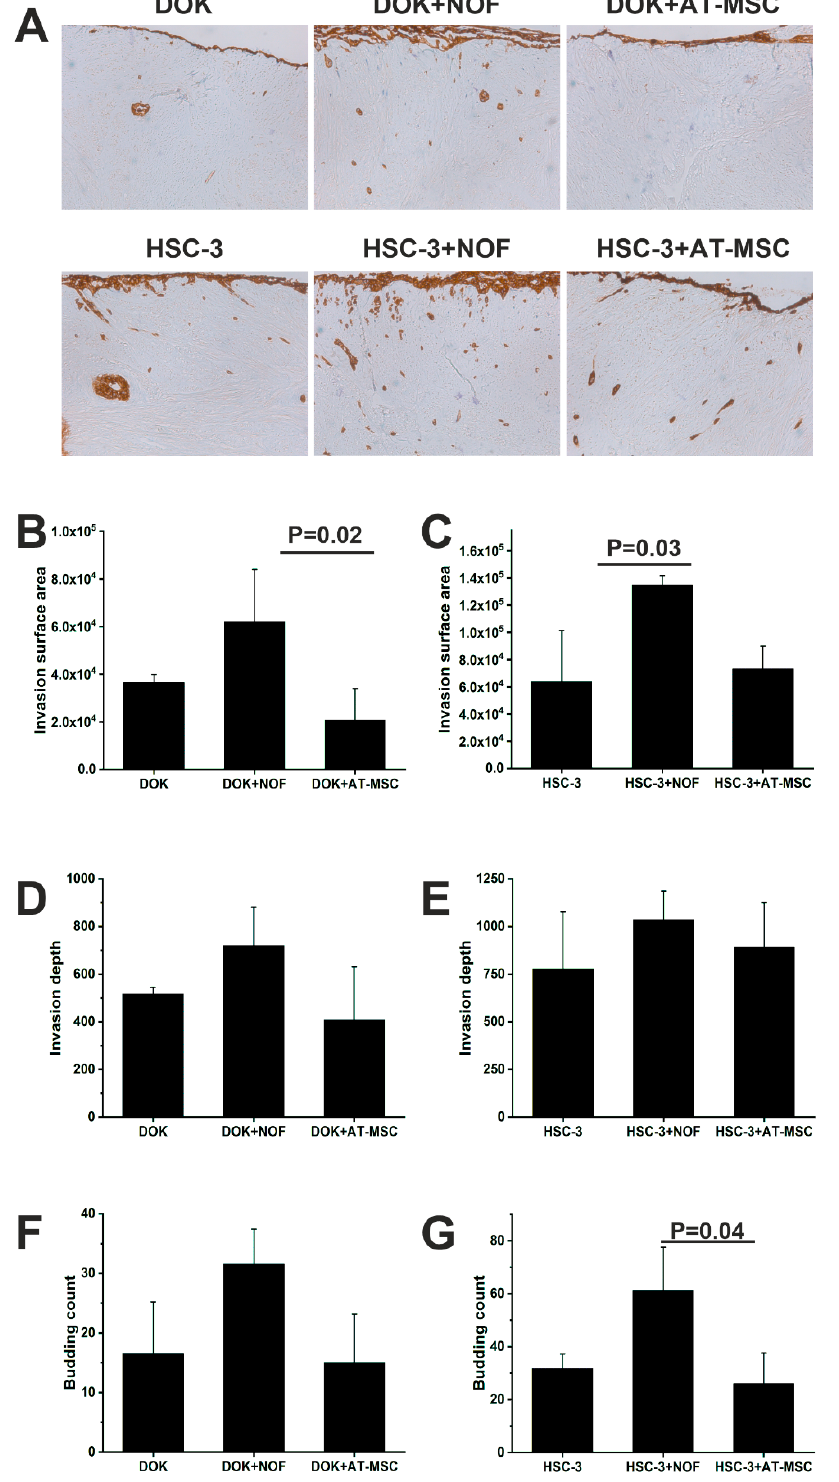
Figure4. InvasionofDOKandHSC-3cellswasnotaffectedbythepresenceofAT-MSCs. ( A )Representative pictures of the pan-cytokeratin-stained cells in the myoma discs, pictures were taken at magnification 4 × . DOK ( B,D,F ) and HSC-3 ( C,E,G ) cells were co-cultured with AT-MSCs and NOF using myoma organotypic model. Cells’ invasion and their ability to form budding were